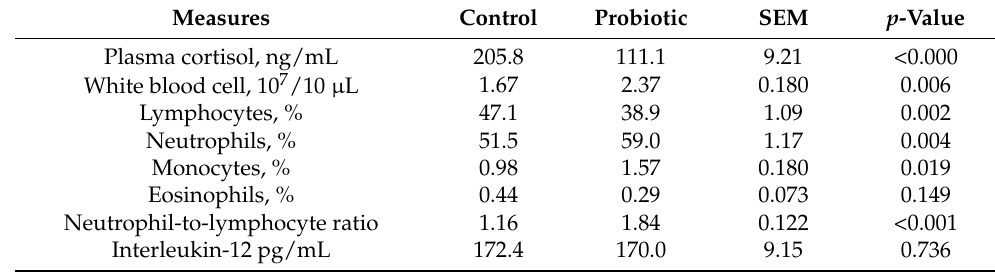
Table 1. Prenatal maternal gestational treatment effects on the progeny mean plasma cortisol, total white blood cell counts, leukocyte differentials, neutrophil-to-lymphocyte ratio, and interleukin-12 at birth (prior to suckling) 1,2